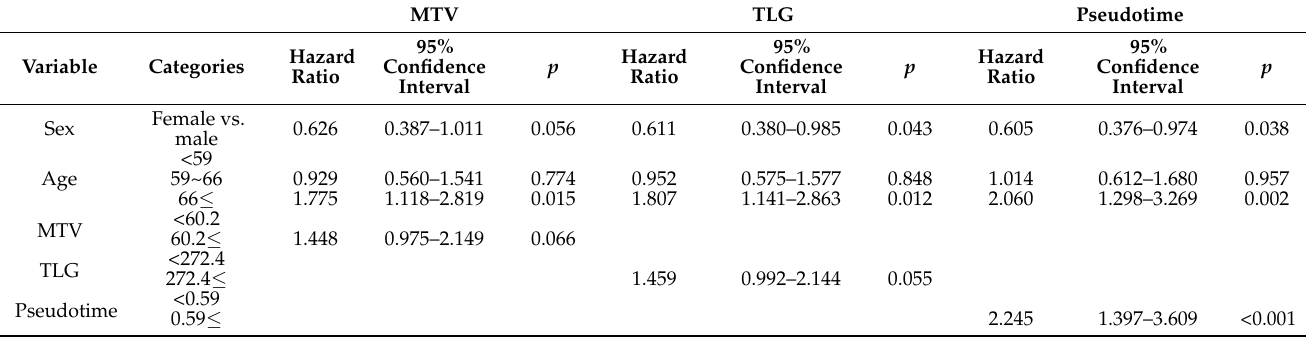
Table 3. Multivariate Cox regression analysis for overall